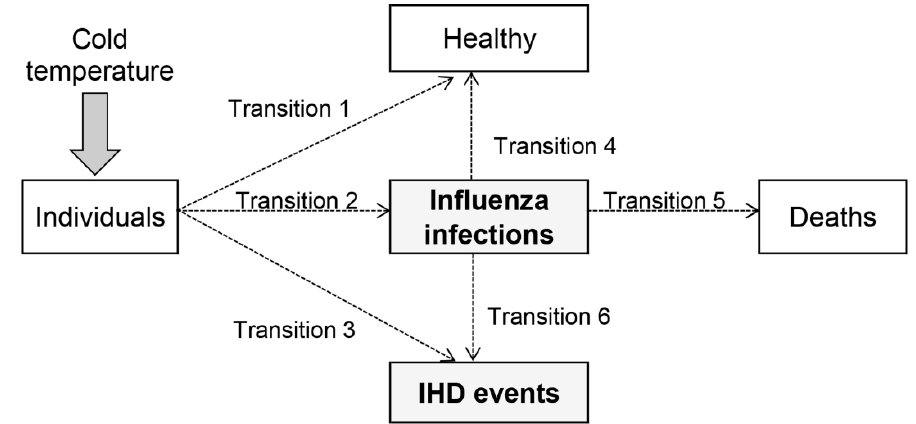
Figure 1. A multi-state competing risk model for influenza infections and IHD mortality or morbidity incidence. Individuals enter the model after being exposed to cold temperatures. First, individuals follow one of transition pathways 1 to 3. Those who followed Transition 2 and entered the state of influenza infections take one of Transitions 4 to 6. The primary IHD occurs when individuals take Transition 3 directly after cold exposure, whereas the secondary IHD occurs if individuals go through Transitions 2 and 6.